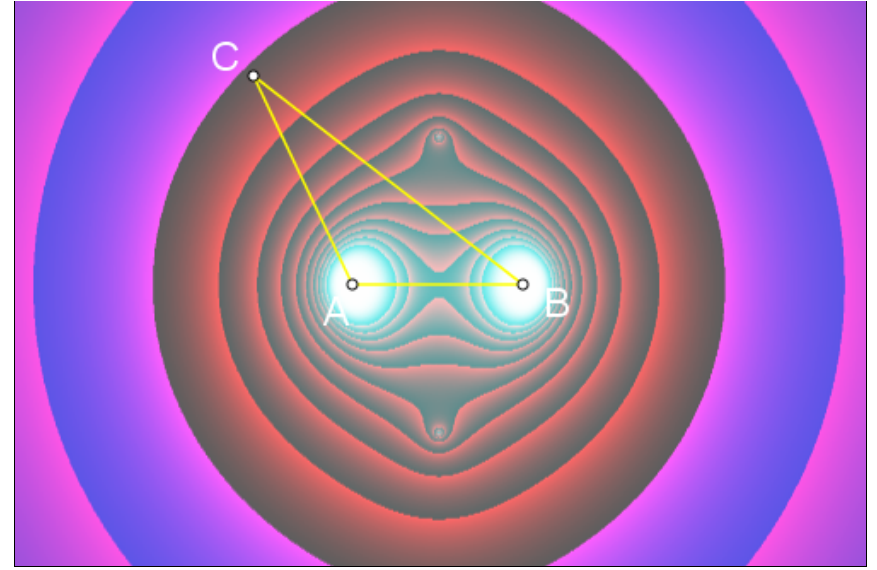
Figure 14. Output after a dynamic color scanning of the plane for the locus P ( x , y ) = 0. Red : e^( −( abs ( k Bi )− floor ( abs ( k Bi ) ) ) ) Green : e^(−abs ( Bi )